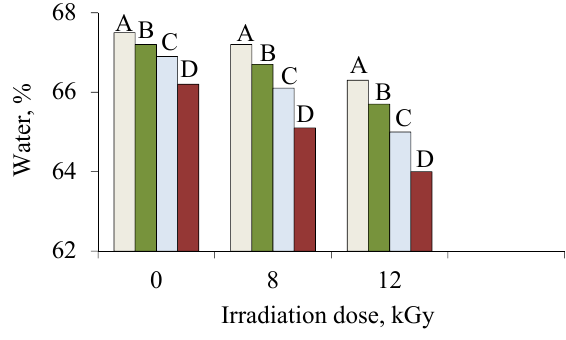
Fig. 8. Dynamics of water content in the control and experimental samples of the refrigerated pork neck on the bone packed using MAP irradiated at different